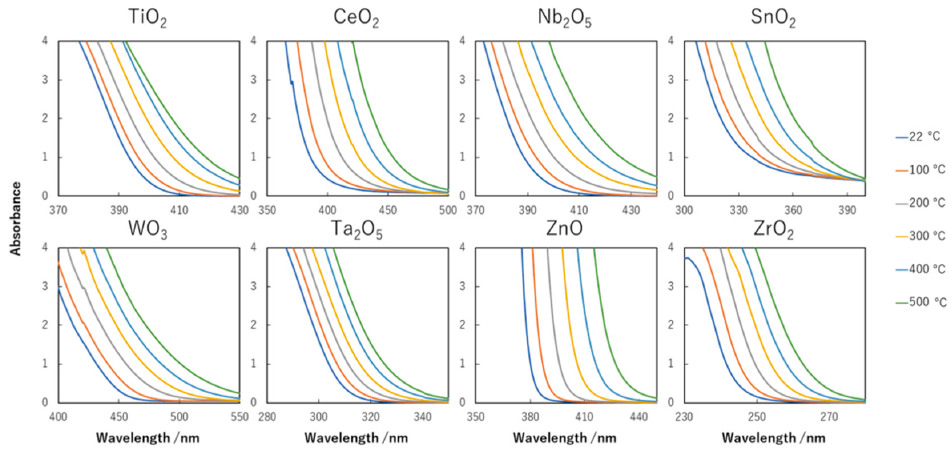
Figure 57. Temperature dependence of the UV-vis absorption spectra for various semiconductors. Reprinted from [73] with permission of AIP Publishing.